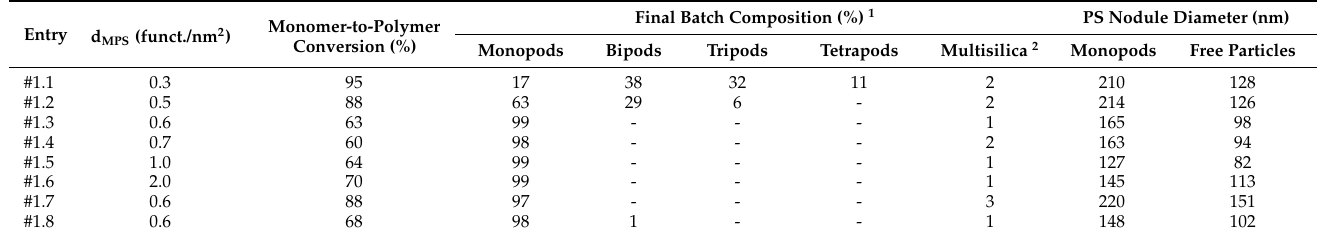
1 Fractions expressed with respect to the silica seeds, i.e., free PS particles were not considered. 2 Multisilica are silica/PS particles made of two or more silica